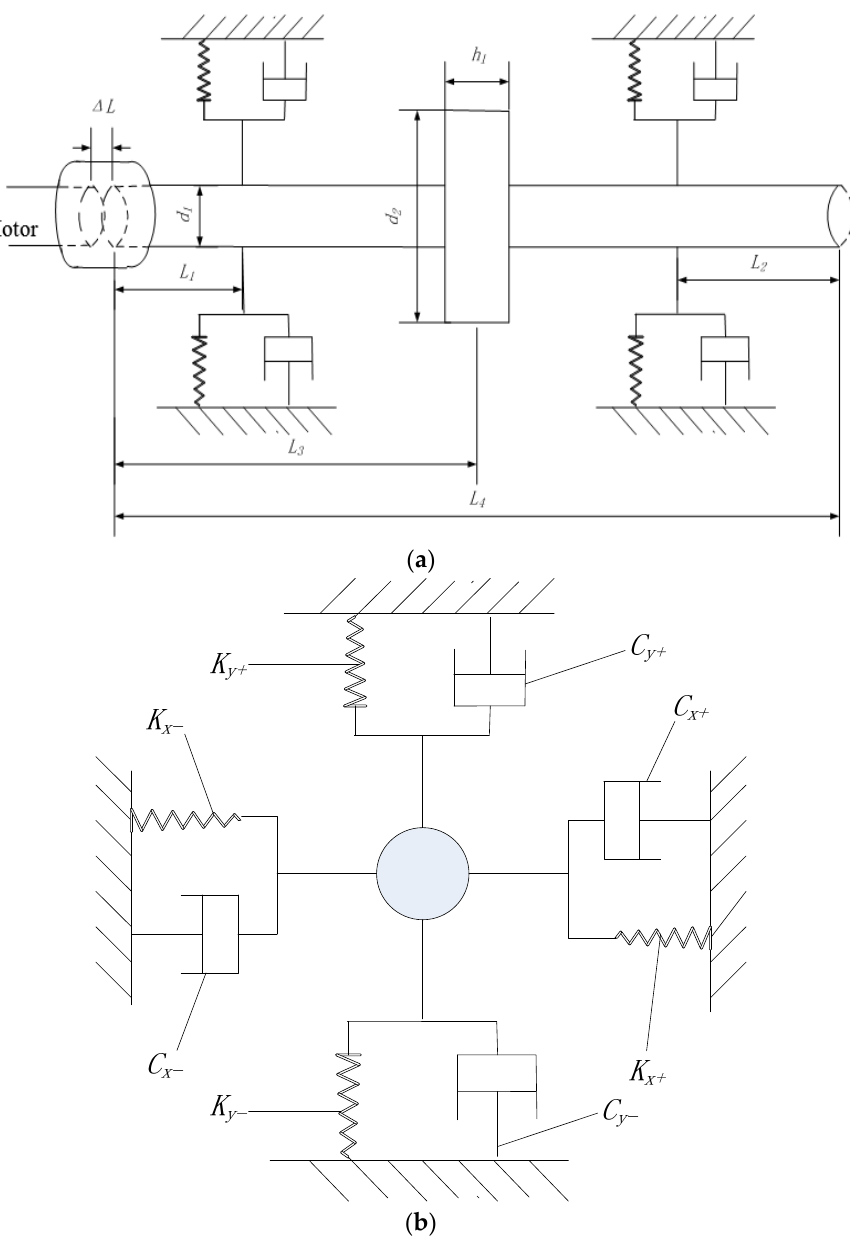
Figure 4. The finite element model of the shaft. ( a ) The geometry of the shaft, note: L 1 =0.1 m, L 2 = 0.1 m, L 3 = 0.25 m, L 4 = 0.5 m, d 1 = 0.01 m, d 2 = 0.078 m, h 1 = 0.01 m, ∆ L =0.002 m; ( b ) the linear bearing